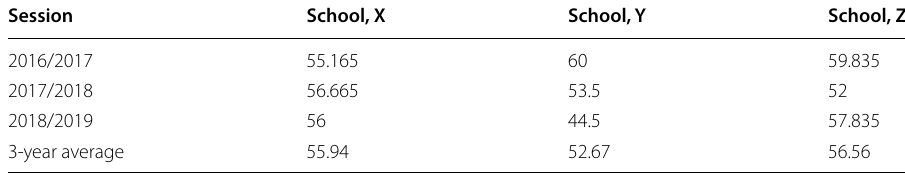
Table 5 Sessional average in the English Language in Junior Secondary School 1